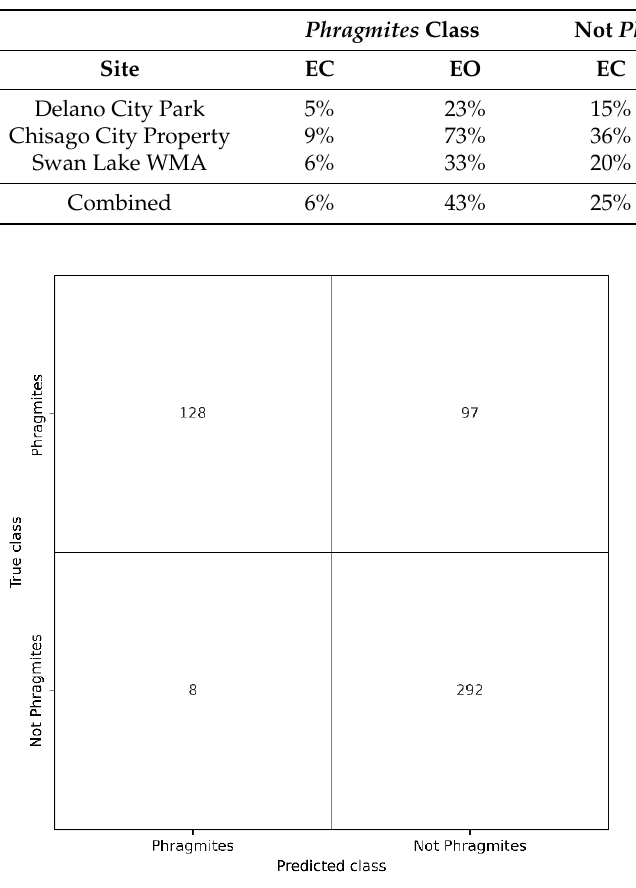
Figure 14. Combined confusion matrix for the three validation sites classified using a support vector machine without the post-ML OBIA rule set. A classification accuracy of 80% was achieved. The Phragmites class had a producer’s accuracy of 54% and a user’s accuracy of 94%. The Not